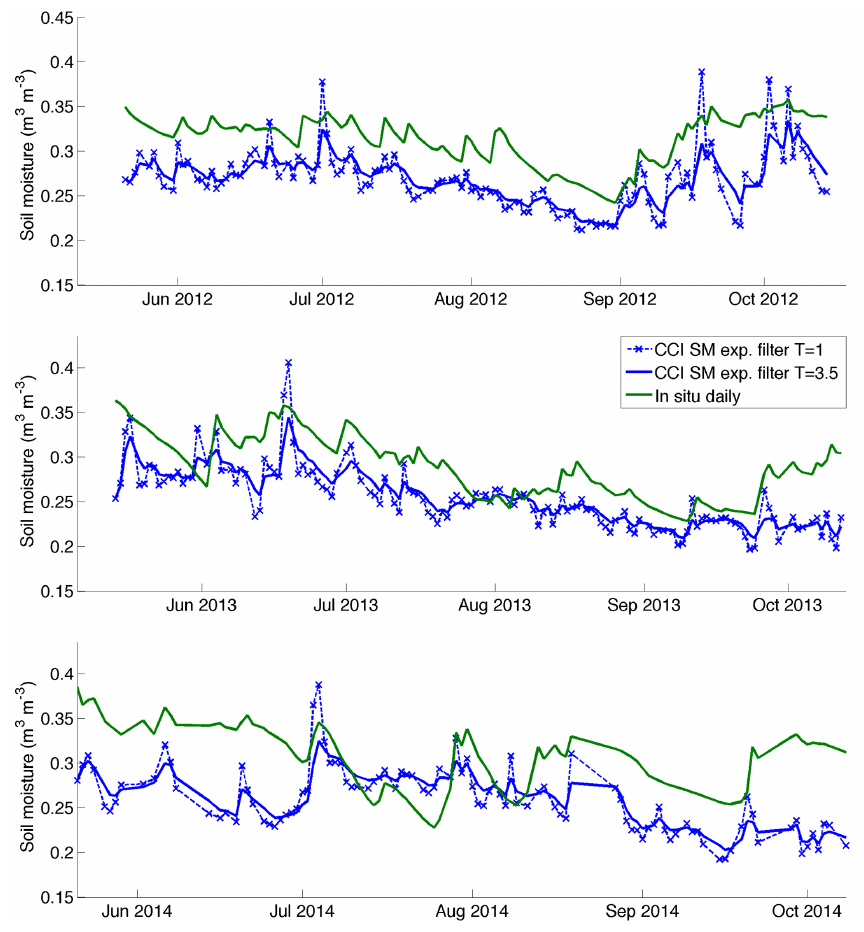
Figure 9. Time series of daily averaged top soil layer ESA CCI soil moisture data product estimates using exponential filters with T parameter values of 1 and 3.5 in comparison against spatially weighted areal average daily in situ observations for the years 2012, 2013, and